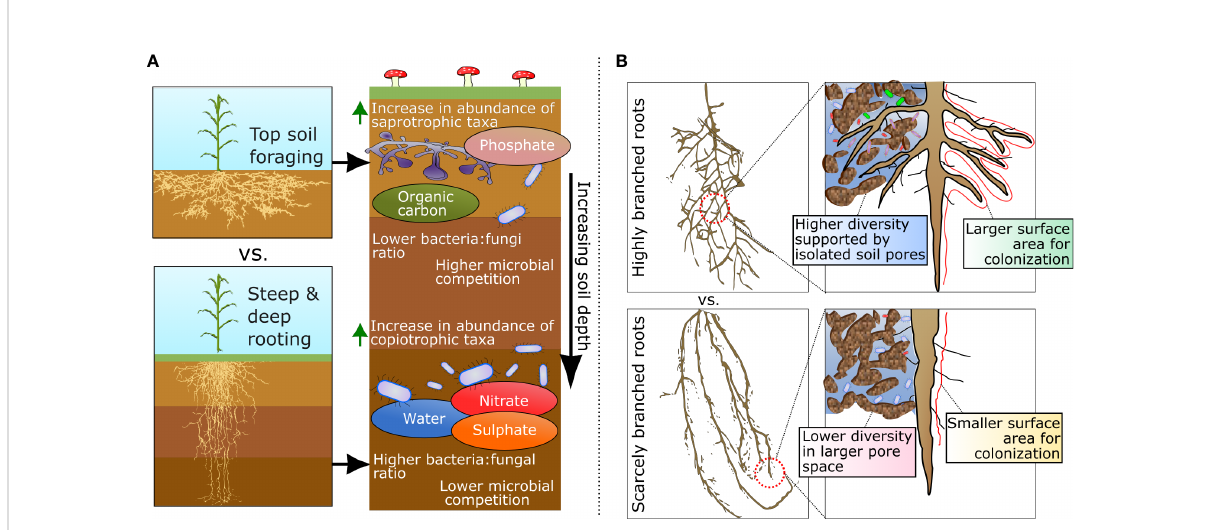
FIGURE 1 (A) Differences in root architecture based on the spatial distribution of roots through the soil pro fi le and the differential distribution of microbial taxa and resources in the rhizosphere with increasing soil depth. (B) Variation in root branching and its in fl uence on mediating the establishment and distribution of microhabitats in the